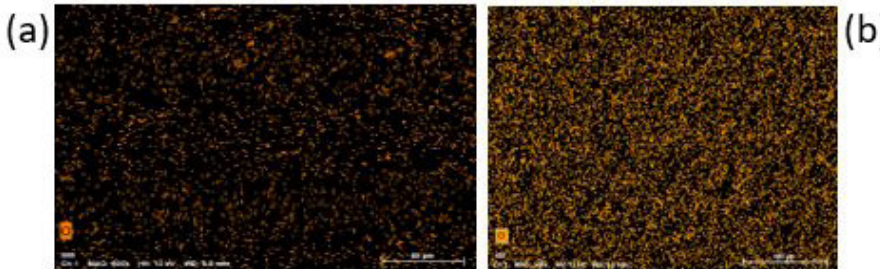
Figure 6. Analysis by EDS Mapping: (a) amount of O in the “as received” sample; (b) amount of O in the sample heat treated at 595